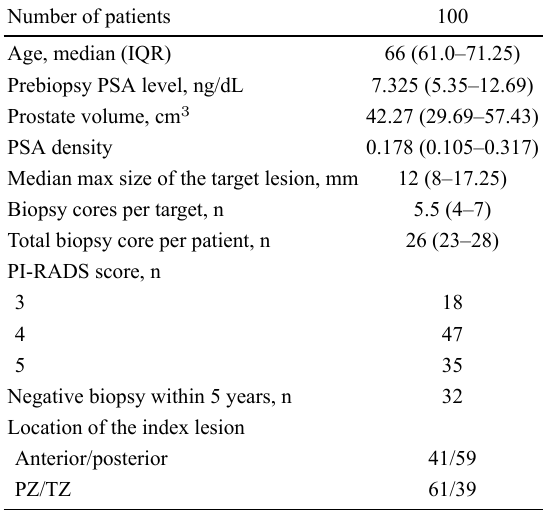
Table 1. Patient characteristics.